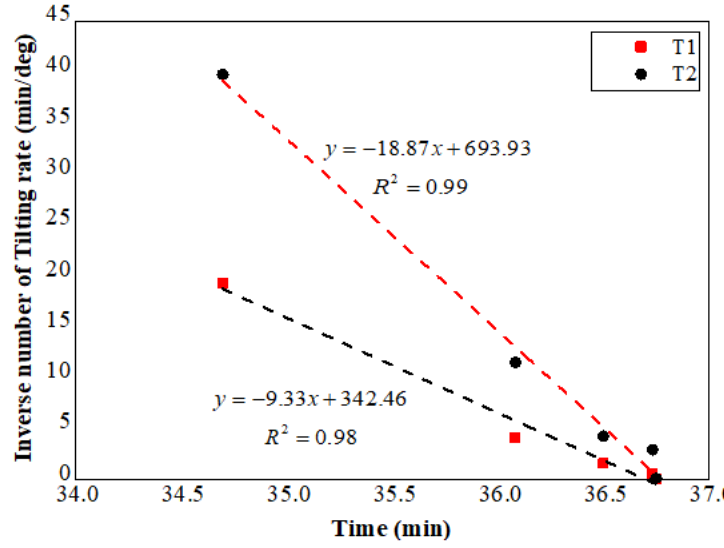
Figure 7. Time series of the reciprocal displacement rate of E1 and E2.